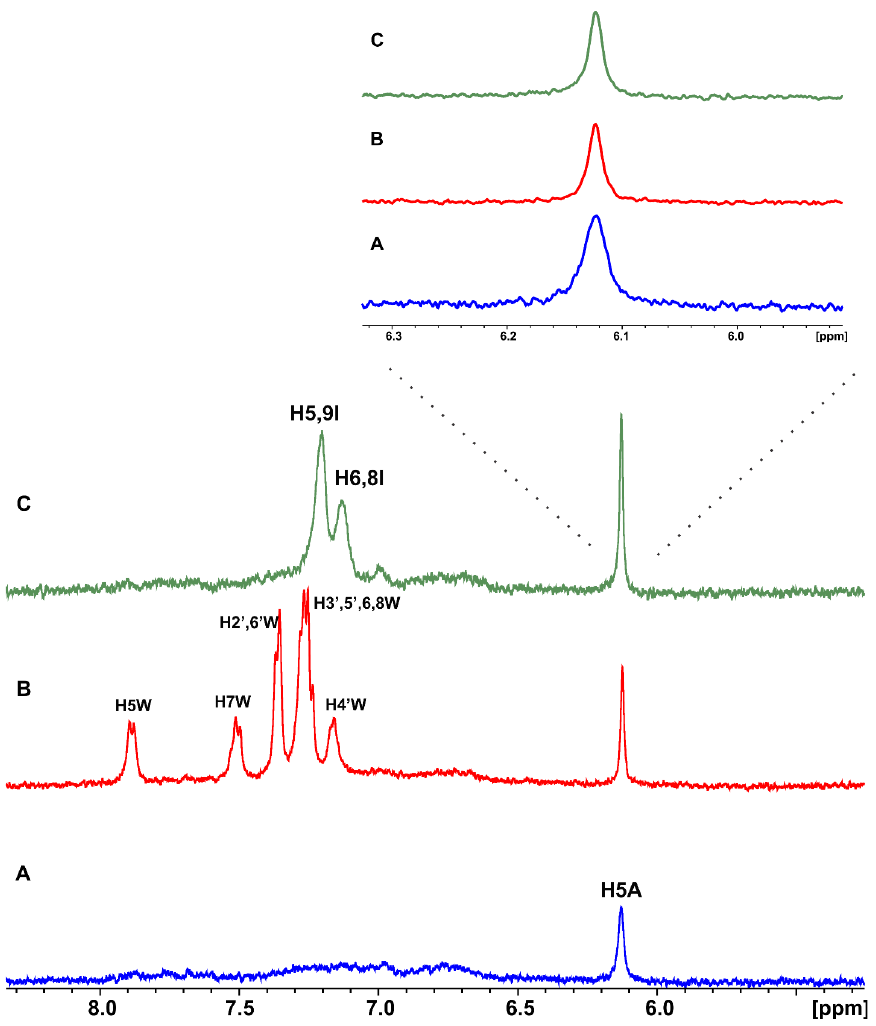
Figure 5. ( A ) Selected regions of 1 H NMR of 2 mM artemisinin with 20 μM BSA in PBS, p D 7.4, D 2 O with 10% DMSO-d 6 , ( B ) after the addition of 2 mM warfarin and ( C) after the addition of 1 mM